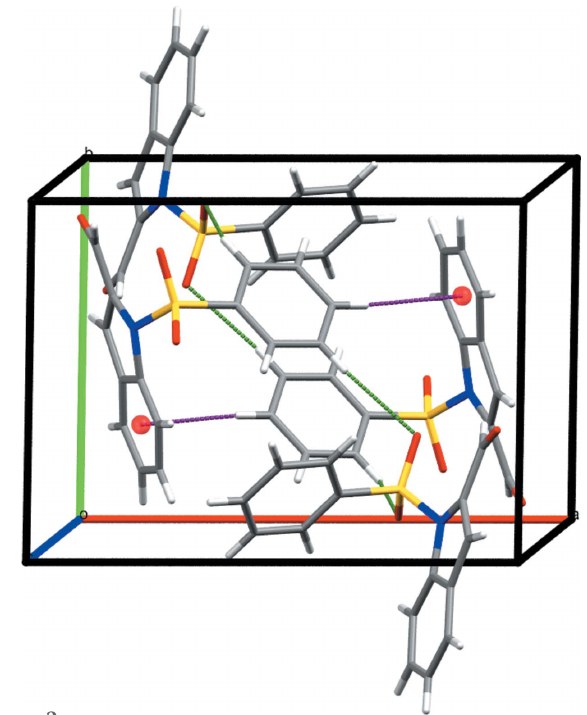
Figure 2 Packing view of the title compound. C—H (cid:3)(cid:3)(cid:3) O and C—H (cid:3)(cid:3)(cid:3) (cid:2) inter- actions are shown as green and purple dashed lines, respectively.